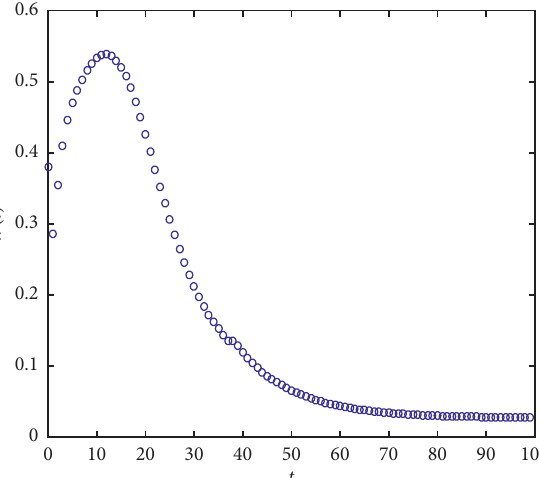
Figure 2: Evolution of individual opinions during reversal (I).